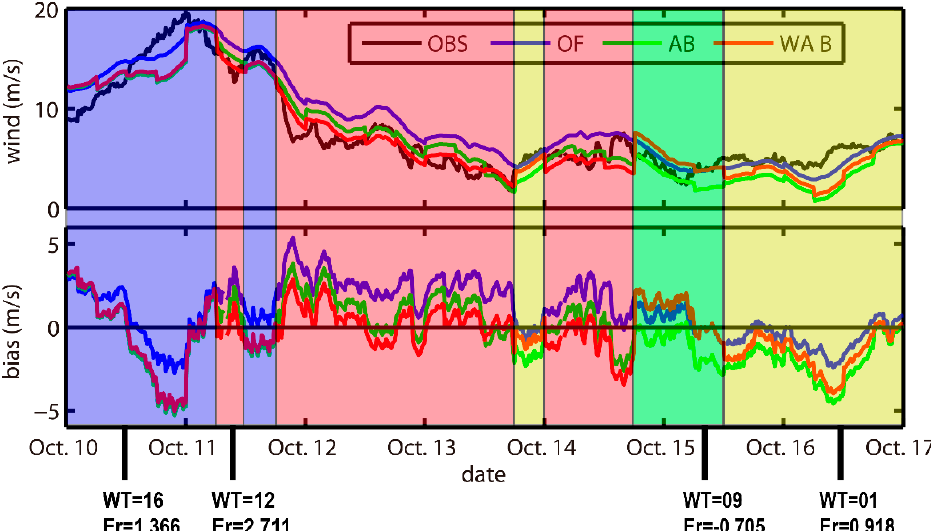
Figure 7. Original (OF, the blue solid line) and two corrected predictions (AB, the green line and WAB, the red line) outputs and observation data (real, the black), and corresponding forecast biases (solid lines in subplot below), with weather types in each period highlighted by background color. In lines below axis, WT shows the number of each period’s weather type, and Er means the corresponding typical bias of that weather type, which have been listed in Table A2 in Appendix A.